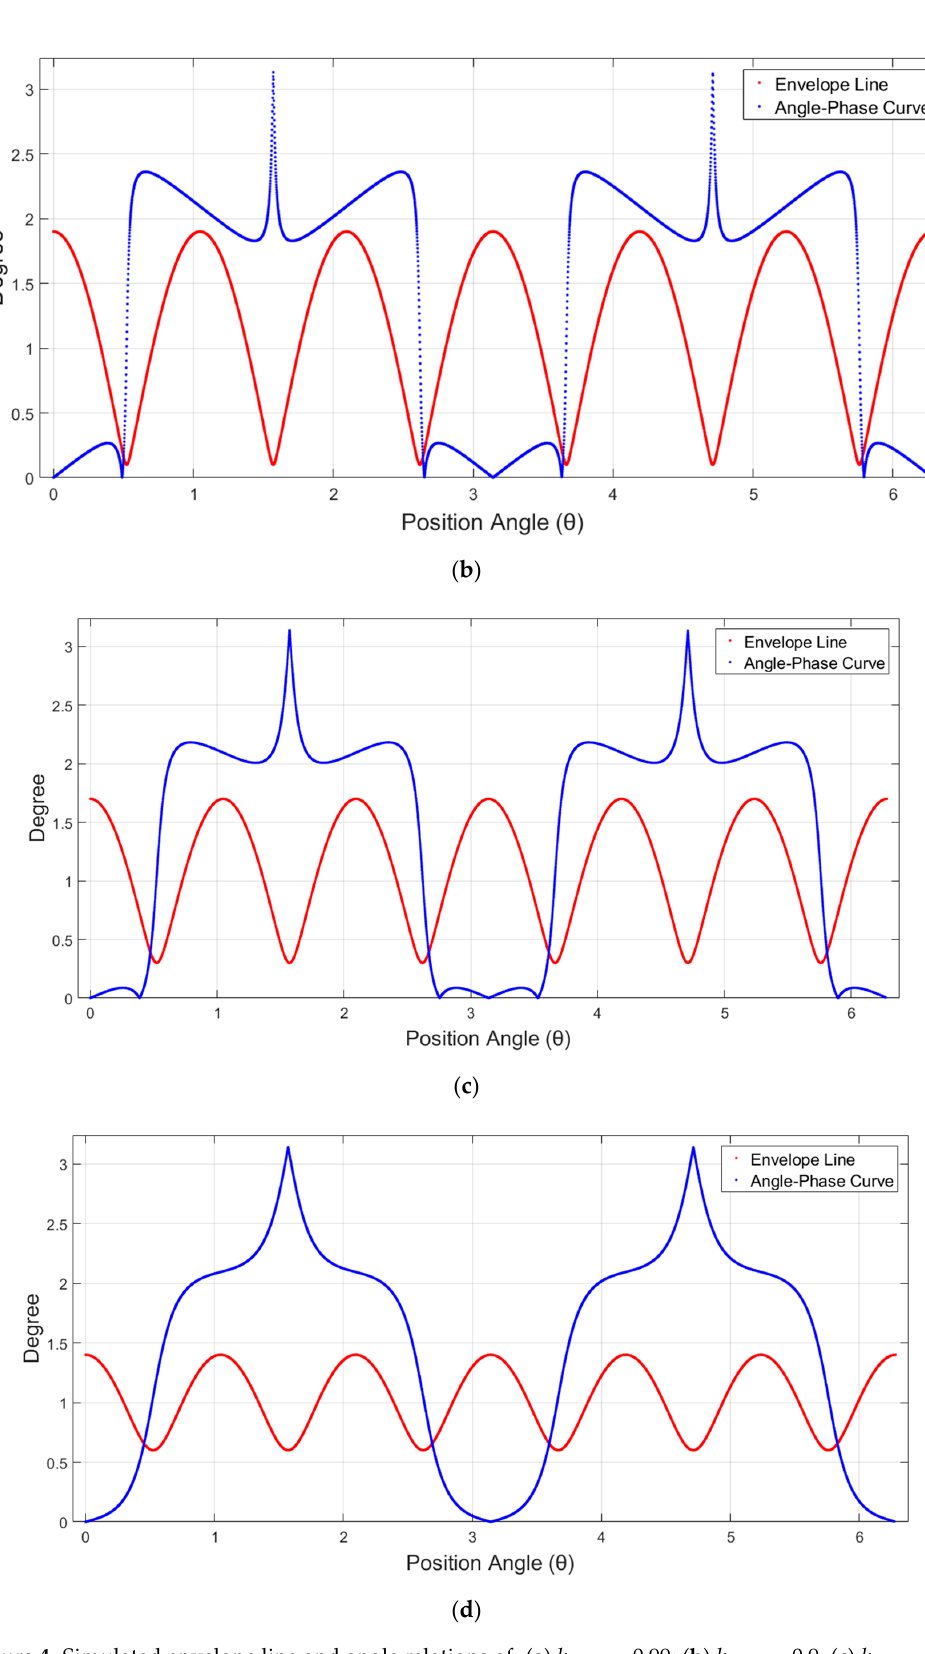
Figure 4. Simulated envelope line and angle relations of: ( a ) 𝑘 (cid:3028)(cid:3040)(cid:3043) = 0.99 ; ( b ) 𝑘 (cid:3028)(cid:3040)(cid:3043) = 0.9 ; ( c ) 𝑘 (cid:3028)(cid:3040)(cid:3043) = 0.7 ; ( d ) 𝑘 (cid:3028)(cid:3040)(cid:3043) = 0.4 .